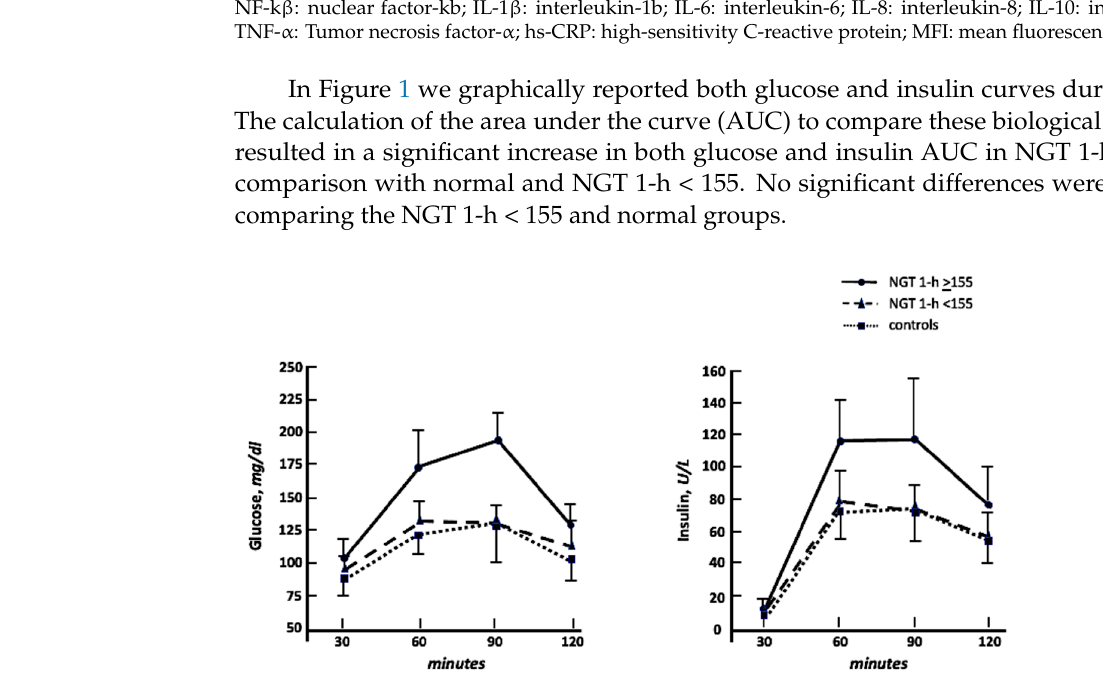
Figure 1. Glucose and insulin curves during oral glucose tolerance test in NGT 1-h ≥ 155, NGT 1-h < 155, and controls.